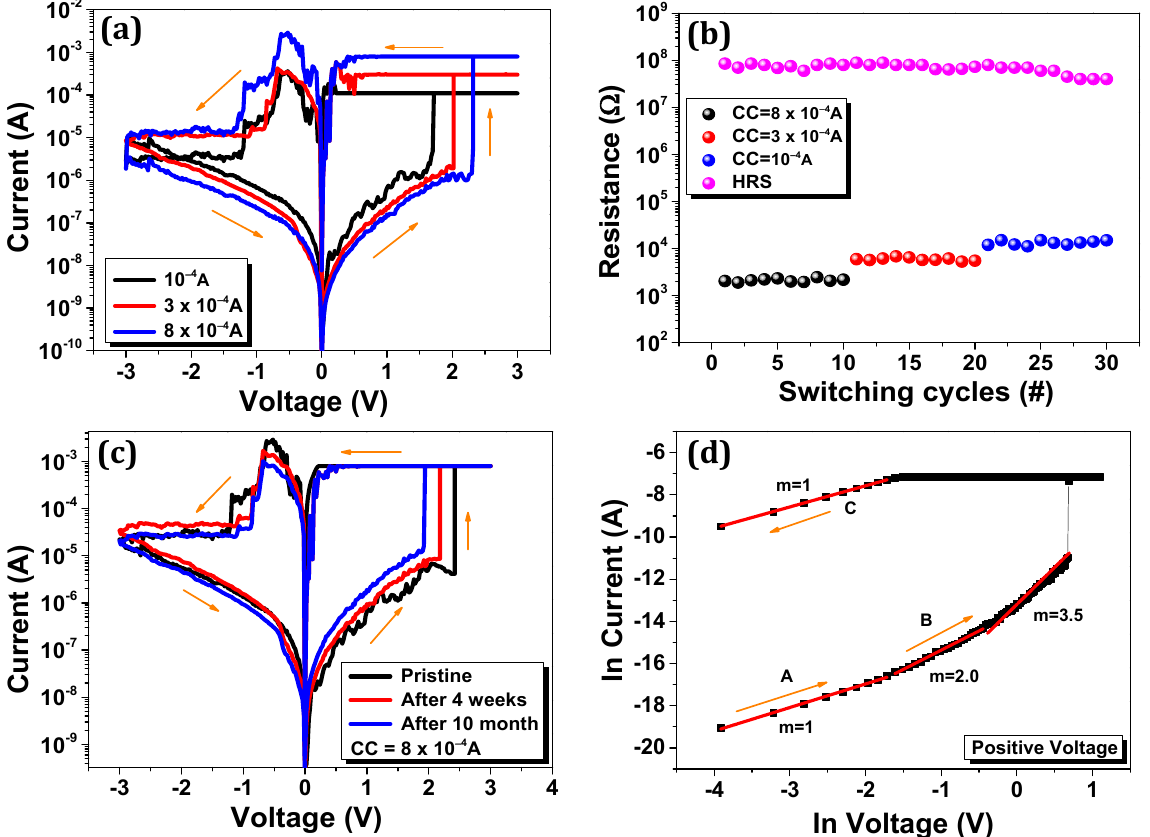
Figure 3. ( a ) I-V characteristics of memory device under different compliance current of 100, 300, and 800 µA, consecutively; ( b ) Multilevel resistance states with distinct current compliance of 800, 300, and 100 µA, consecutively; ( c ) Electrical characterization of the Ag/ZnO/P3HT-PCBM/ITO device after storage in ambient air; ( d ) Double logarithmic I-V curve of Ag/ZnO/P3HT-PCBM/ITO bulk-heterojunction device, illustrating the slope values of linear fitted curve at positive bias. The plot divided into three different regions represented as segment A, segment B, and segment C, respectively.